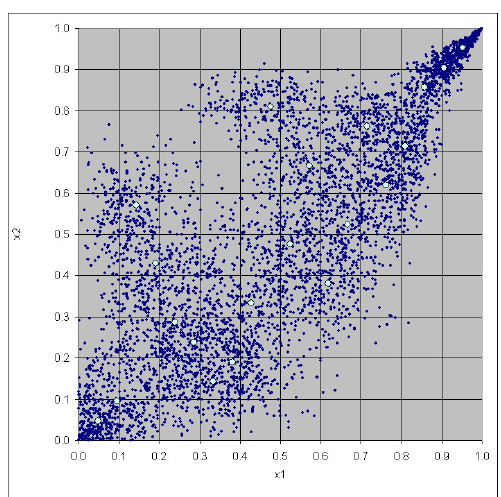
Figure 21. NB rook copula, a = 15.